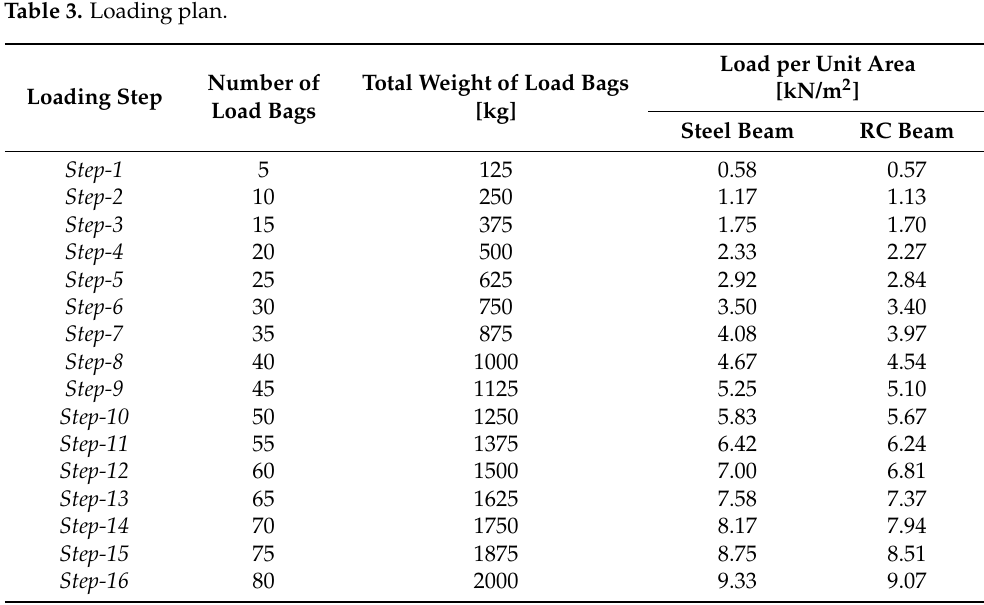
Figure 4. Photos at Step-2 with 10 load bags and Step-16 with 80 load bags.